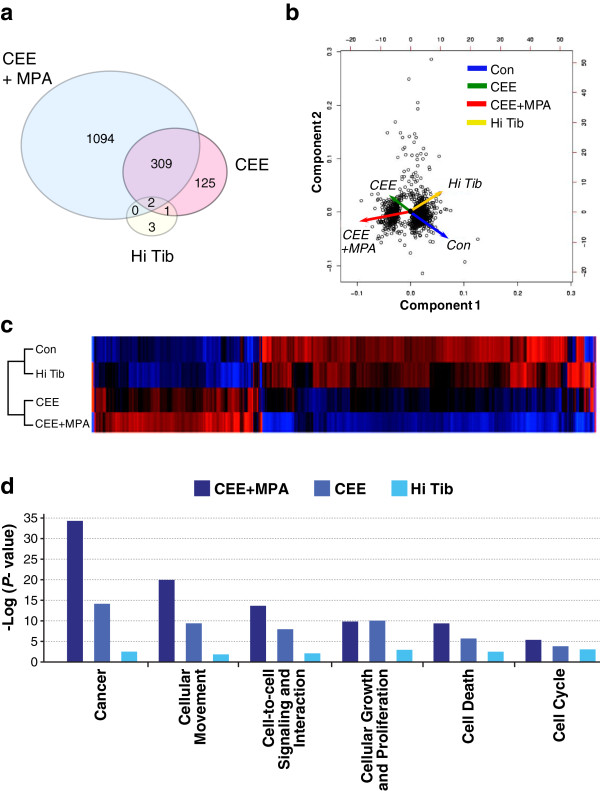
Global transcriptional patterns in the breast tissue following treatment with control (placebo), conjugated equine estrogens (CEE), CEE + medroxyprogesterone acetate (MPA), and high-dose tibolone (Hi Tib). (a) Venn diagram showing greater numbers of genes altered by CEE + MPA compared with CEE and Hi Tib. (b) principal component analysis and (c) heatmap of differentially regulated genes showing greater overlap between Con and Hi Tib groups and the CEE + MPA and CEE groups. (d) Functional categories of significantly altered transcripts showing overrepresentation of genes involved in cancer and several related classes. mRNA profiles were determined by microarray analysis. All diagrams correspond to significantly altered transcripts with fold-change of more than 1.5 versus control group in at least one group, adjusted analysis of variance (ANOVA) P < 0.05, and quality more than 2.